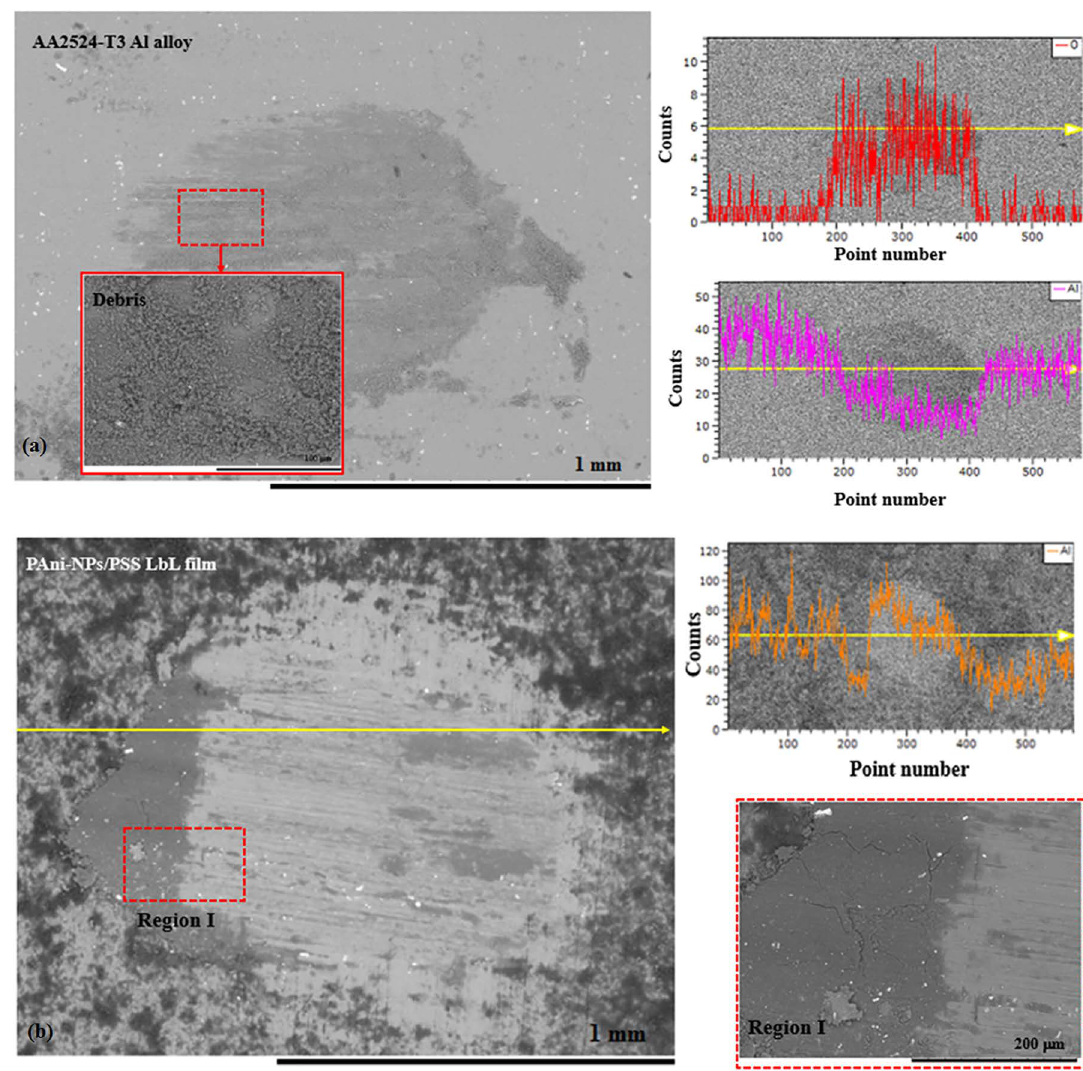
Figure 8. Micrographs of the (a) AA2524-T3 alloy and the (b) bare material coated with PAni-NPs/PSS LbL after the micro abrasive wear